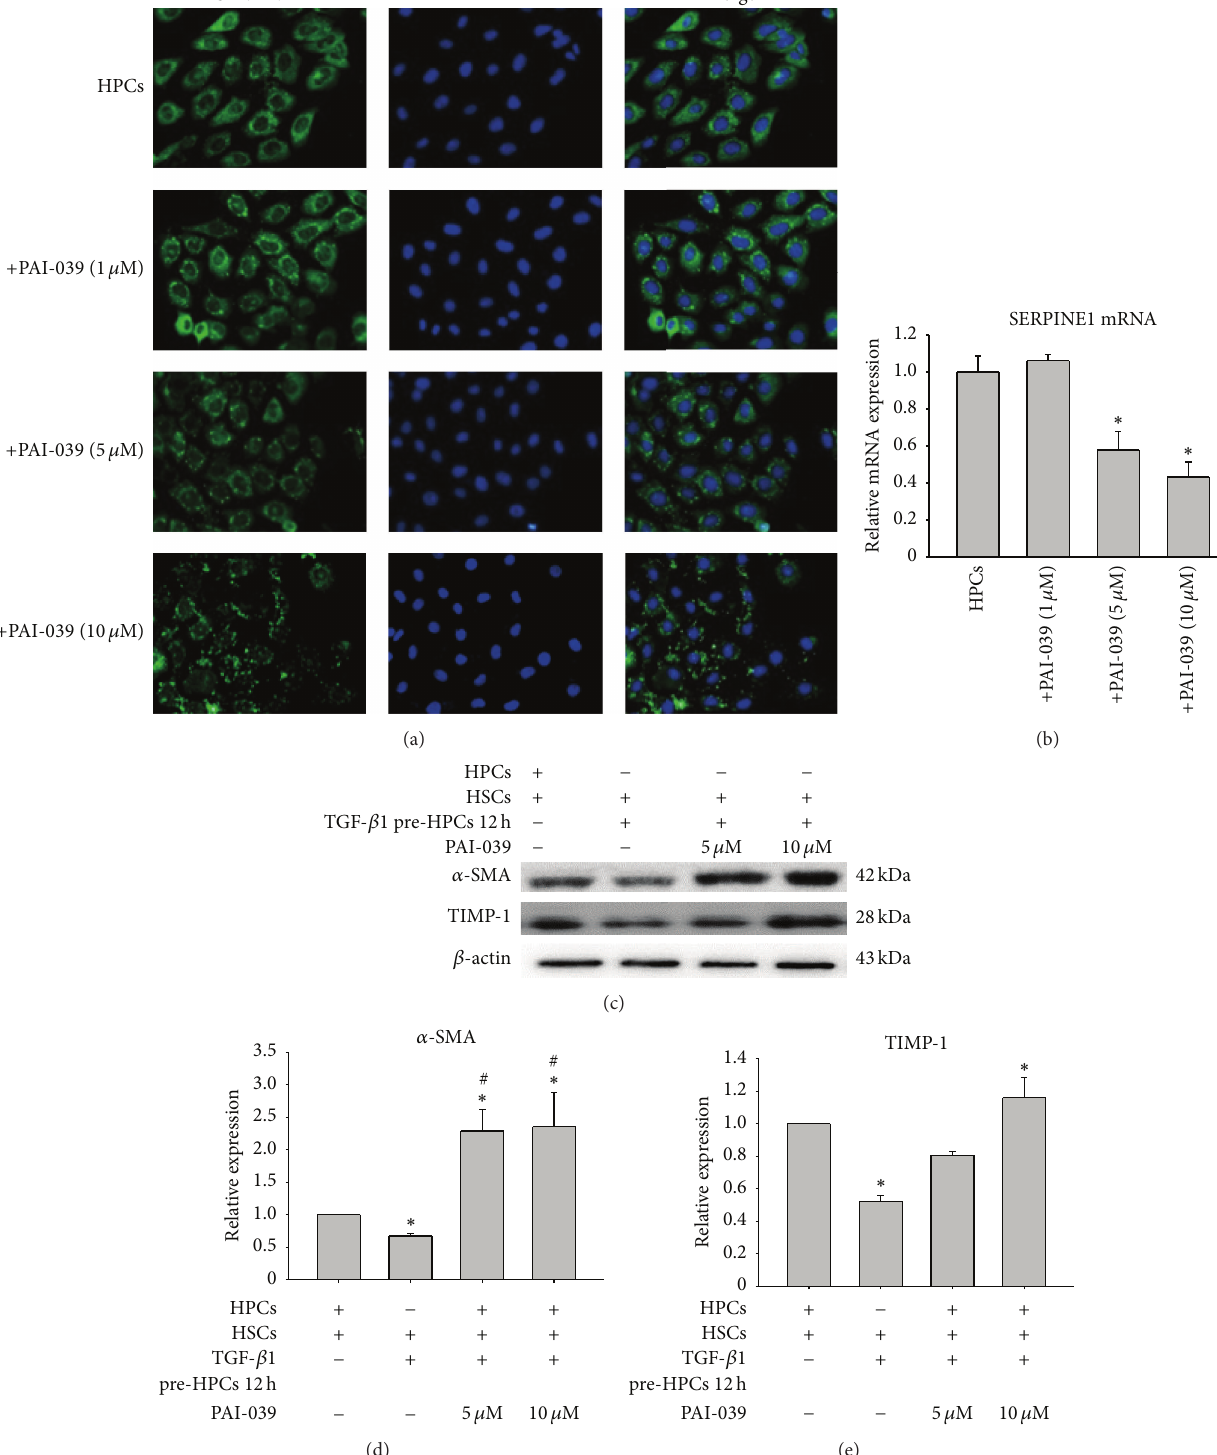
Figure 7: Influence of the SERPINE1 inhibitor on HSC activation after HSCs were cocultured with HPCs pretreated with TGF- 𝛽 1 for 12h. After incubation with various concentrations of the SERPINE1 inhibitor PAI-039 (0–10 𝜇 M) for 48 h, SERPINE1 expression was inhibited significantly as shown by immunofluorescence (a) and real-time PCR (b) analyses. Suppression of SERPINE1 expression prevented the response of HSCs to HPCs. Data are expressed as the mean ± SD from three independent